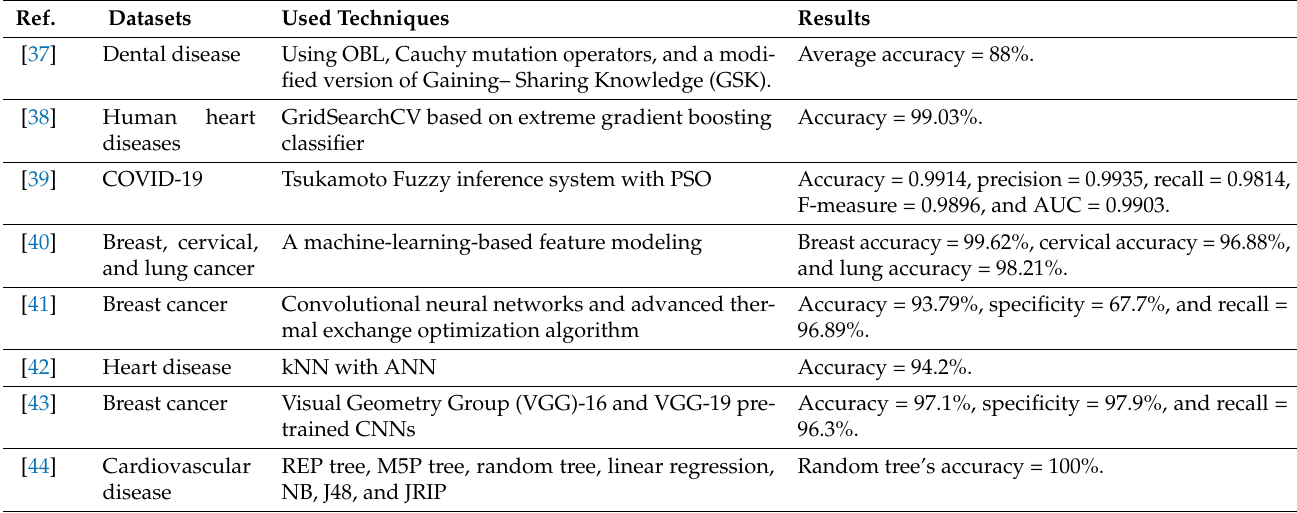
Table 1. Related works in the literature based on ML and optimization